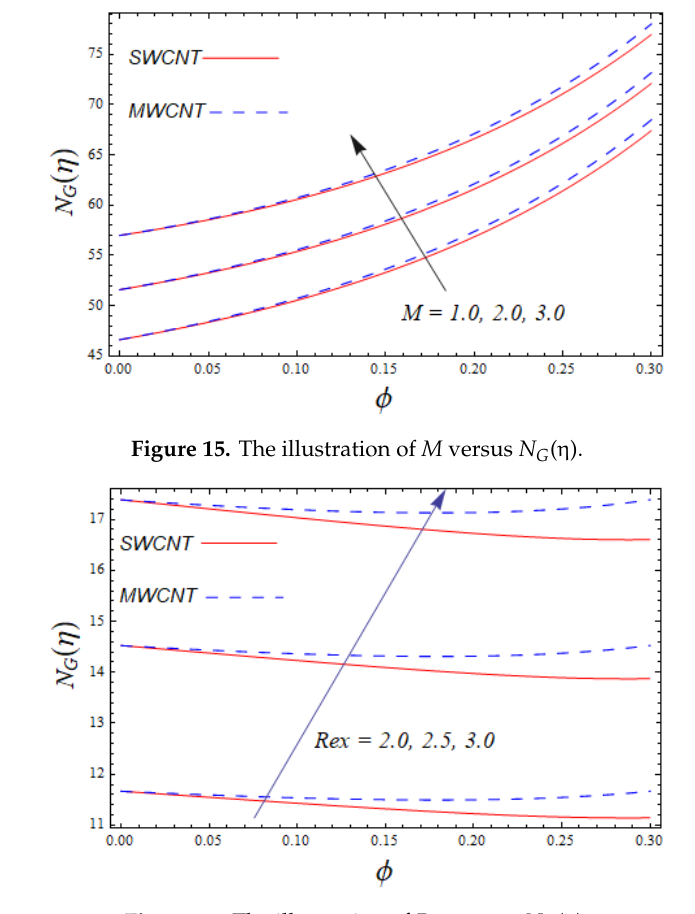
Figure 16. The illustration of Re x versus N G (η).